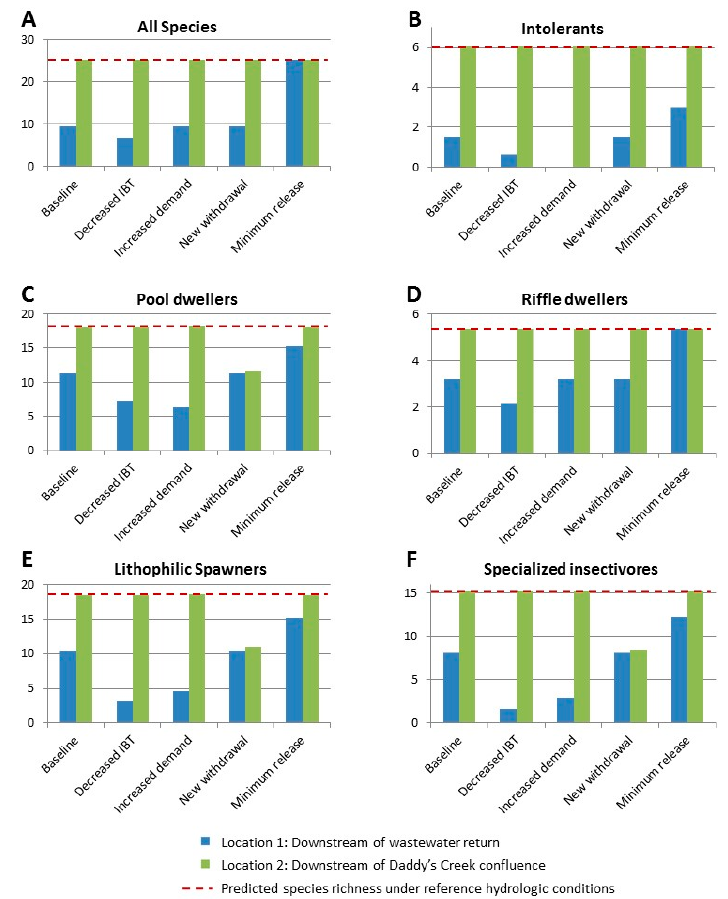
Figure 4. Predicted fish species richness for model Locations 1 and 2 based on water-use scenarios for: ( A ) all species; ( B ) intolerants; ( C ) pool dwellers; ( D ) riffle dwellers; ( E ) lithophilic spawners; and ( F ) specialized insectivores; see Table I in [52] for fish category definitions; dashed black lines indicate predicted species richness under reference hydrologic conditions (i.e., intercept values from flow–ecology relationships, see Figure S2 and Table S2).